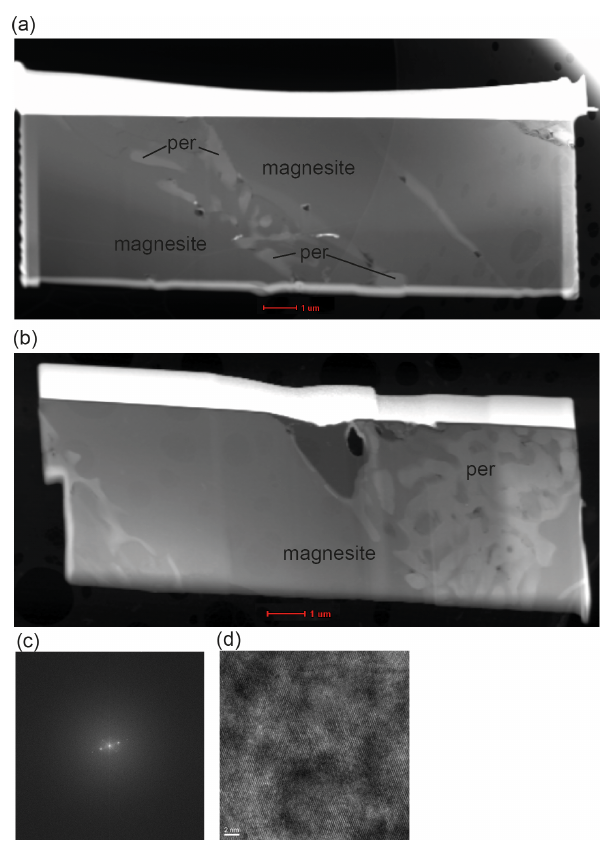
Figure 5. Overviews of FIB foils, sample MA 507 (a) and MA 523 (b) ; (c) FFT diffraction pattern of periclase from HREM image (d) of sample MA